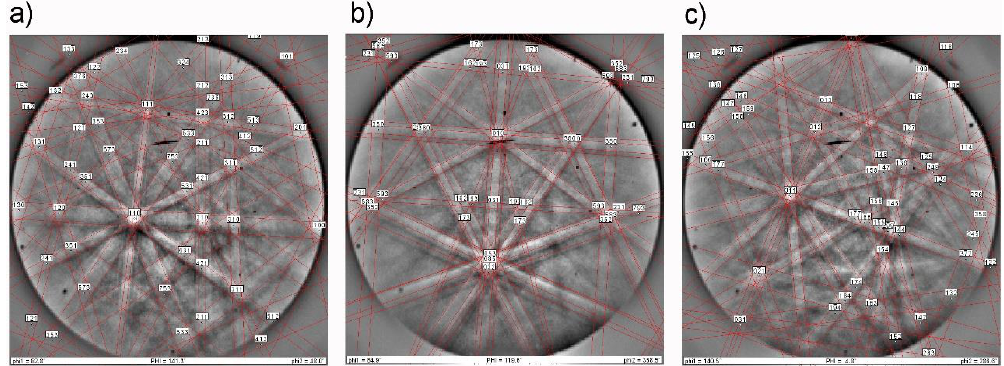
Figure 7. Experimental patterns by electron back-scattered diffraction acquired from ( a ) Al 2 Cu, ( b ) α -Fe and ( c ) β -Fe phases with superimposed tetragonal (space group, s.p. I4/mcm), cubic (s.p. Pm-3) and monoclinic (s.p. 2/m) pattern simulations, respectively.